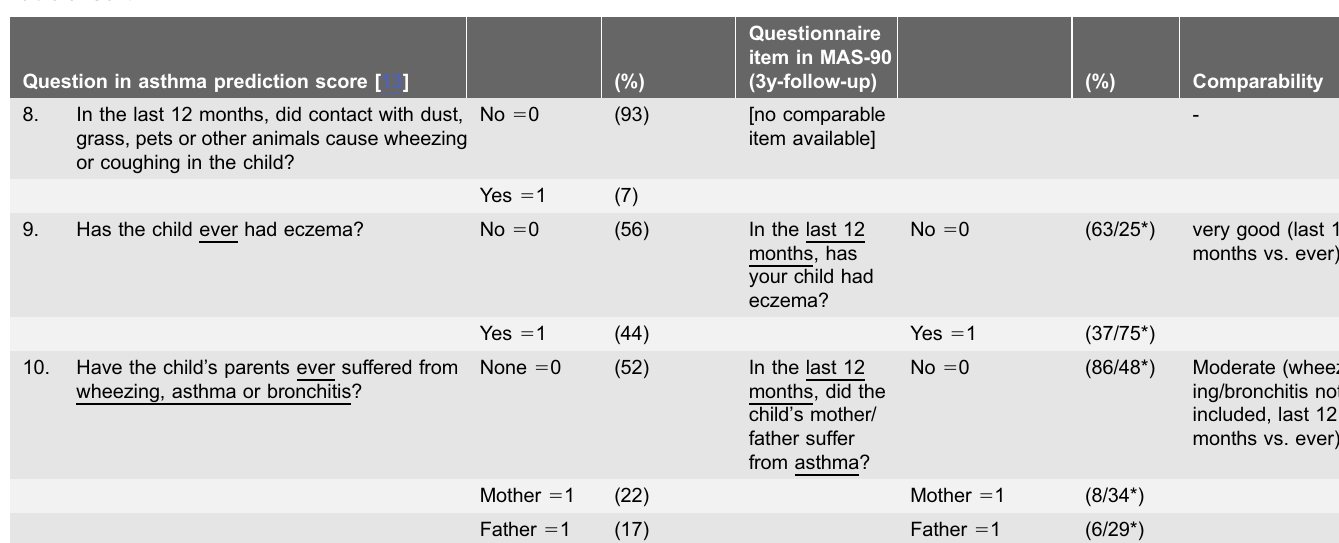
crying or excitement’. Furthermore, parents’ respiratory illness was more common in the Leicester population asking for wheeze, asthma and bronchitis (mother 22%/father 17%), compared to MAS-90 where the question was limited to asthma only (8%/6%). The distribution of actual scores in the validation cohort (mean score 4.2, median 4) was very similar to what we derived from the report of Pescatore et al. (mean score 4.5, median 4). Only the high risk group (score $ 10) was considerably smaller in our sample with 2% vs. 8% (Fig. 1).